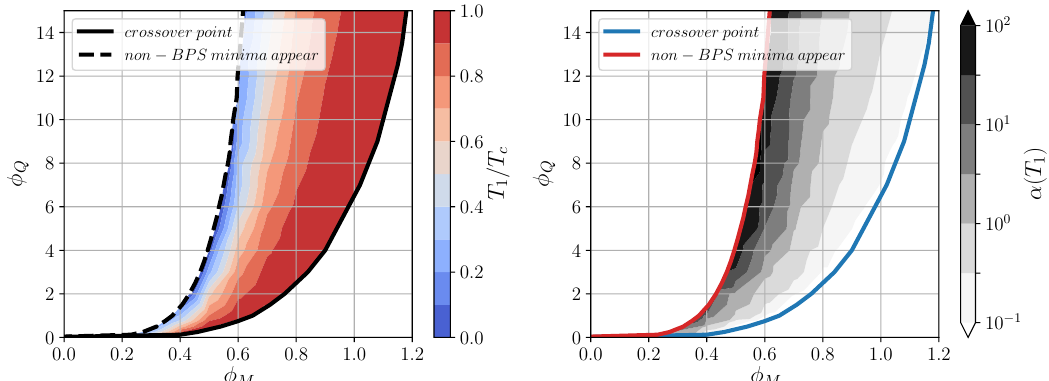
Figure 7 . Left: contours of T 1 /T c in the ( φ M , φ Q ) plane, where T 1 is the lowest temperature at which the metastable phase exists. Right: transition strength parameter α at temperature T 1 .